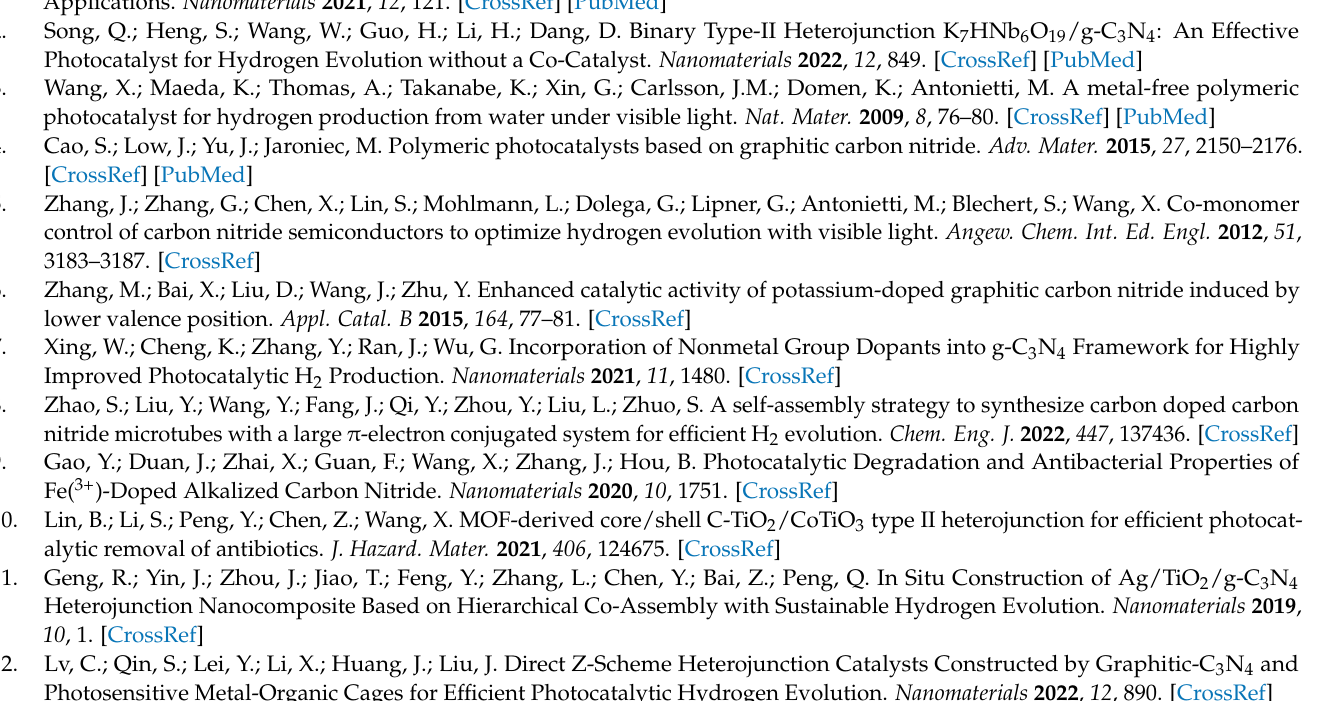
samples; Figure S2: The XPS survey spectra of CNT and PNCNT samples; Figure S3: Time courses of photocatalytic H 2 evolution (a) and H 2 evolution rate (b) of CNT, NCNT, PCNT and PNCNT-x samples under visible light; Figure S4: Plots of (ahv) 1/2 vs. photon energy (a) and XPS-VB of CNT and PNCNT (b); Table S1: The BET surface area, pore volume and average pore size of CNT, NCNT, PCNT and PNCNT samples; Table S2: Portion of each peak in the C 1s XPS spectra of CNT and PNCNT; Table S3: Comparison with other g-C 3 N 4 -based photocatalysts for HER rate. References [40–45] were cited in the Supplementary